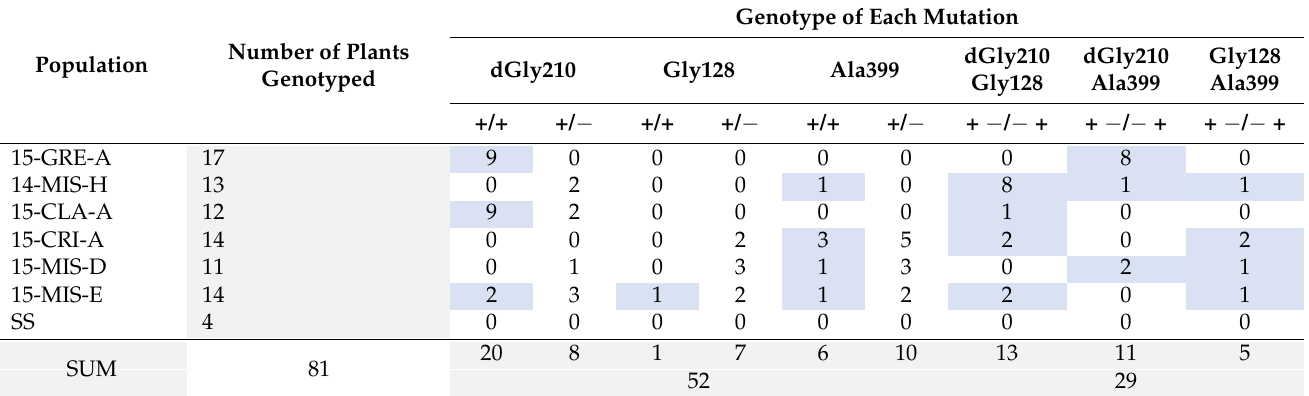
Table 2. The PPO2 mutation profile of survivors from 1x soil-applied fomesafen